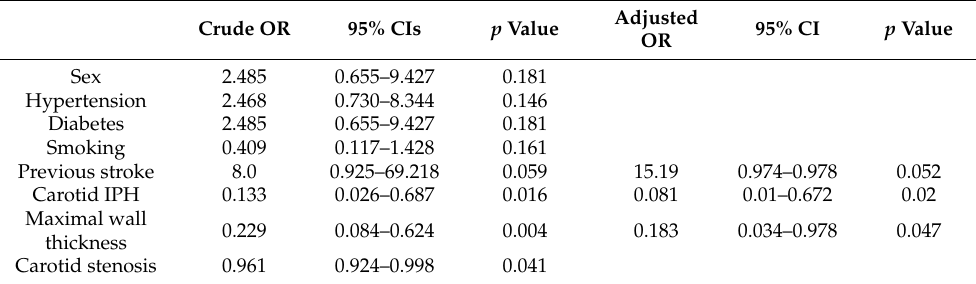
Table 3. Univariate and multivariable analysis associated with SyNC and ESUS. Crude OR 95%